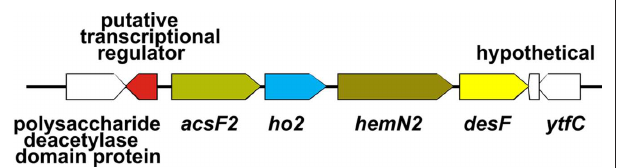
Figure 7 | Organization of the acsF2 gene cluster. The acsF2 gene cluster comprises four genes ( acsF2 , ho2 , hemN2 , and desF ). There is an ORF encoding a putative transcriptional regulator (SYNPCC7002_A1993) in the region upstream from acsF2 but encoded on the opposite